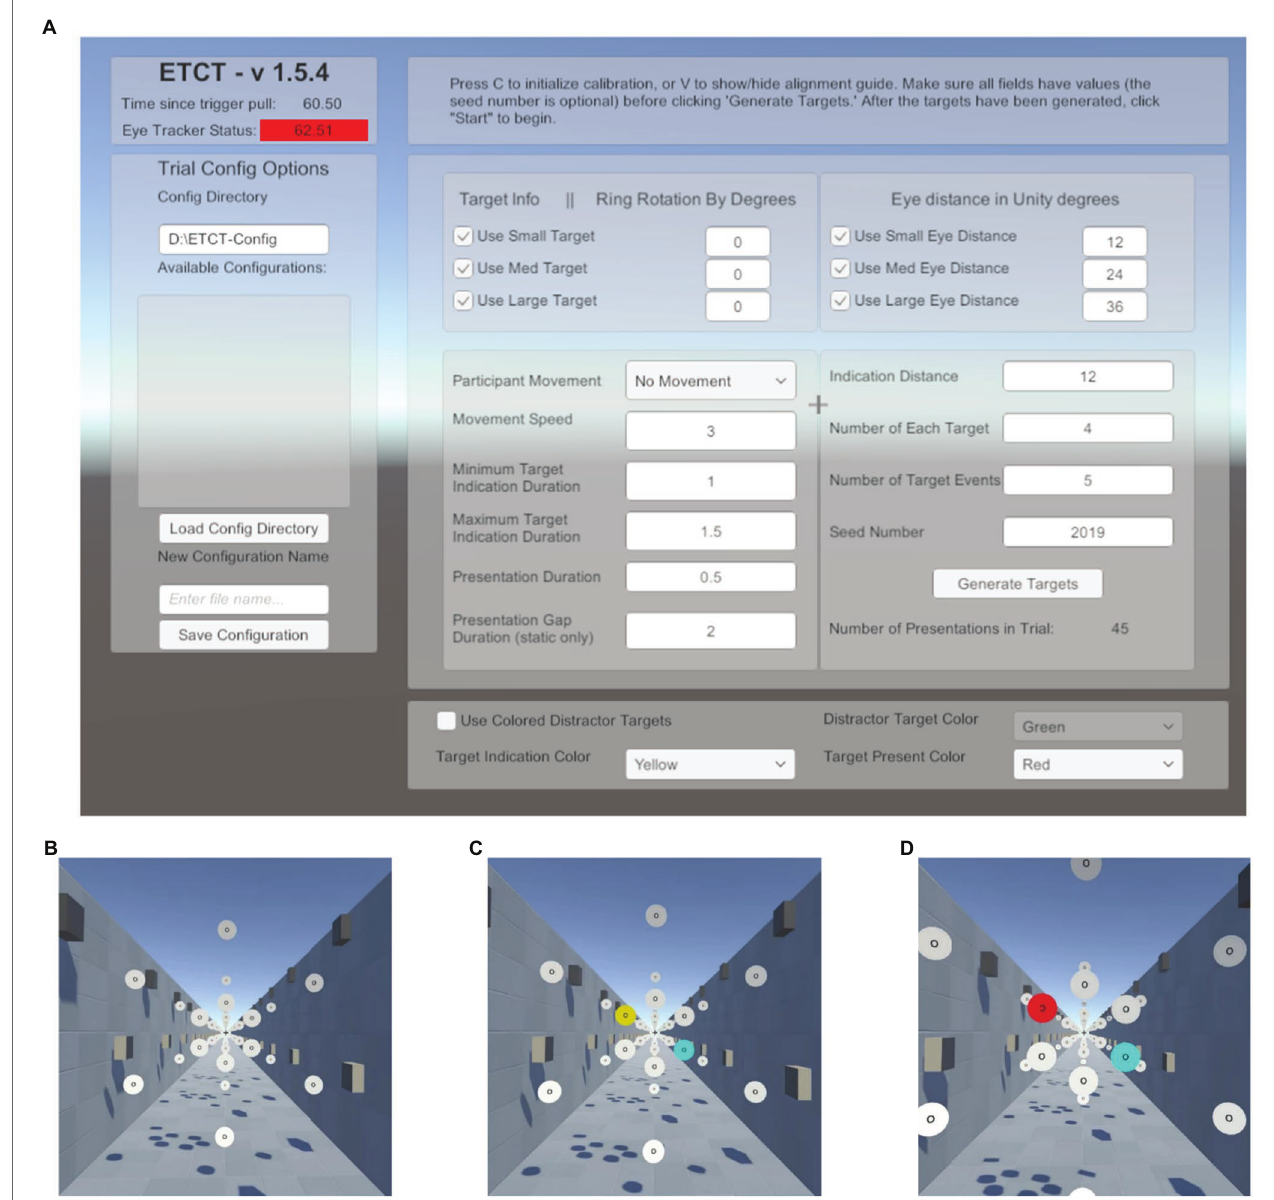
FIGURE 1 | Paradigm schematic. (A) Graphical user interface (GUI) presented at the start of the experiment. Here, the researcher can input a number of parameters to alter stimulus presentation. This list includes target parameters such as size as well as the motion (or lack thereof) of the participant through the environment. A list of available parameters and the values set in the current experiment is included in the Supplementary Materials . (B) Start of a trial. Subjects foveate the recentering cross ahead of them. (C) Target indication phase. Subjects are told to saccade to the yellow disk in preparation for the target and ignore the cyan disk. (D) Target presentation. Subjects must maintain fixation on the yellow disk until the target is presented, at which time the yellow disk turns red and the “O” at the center of the disk is replaced with a “C” facing either the left or the right. Subjects report the direction of the “C” using the virtual reality (VR) controls and return their gaze to the recentering cross to await the next